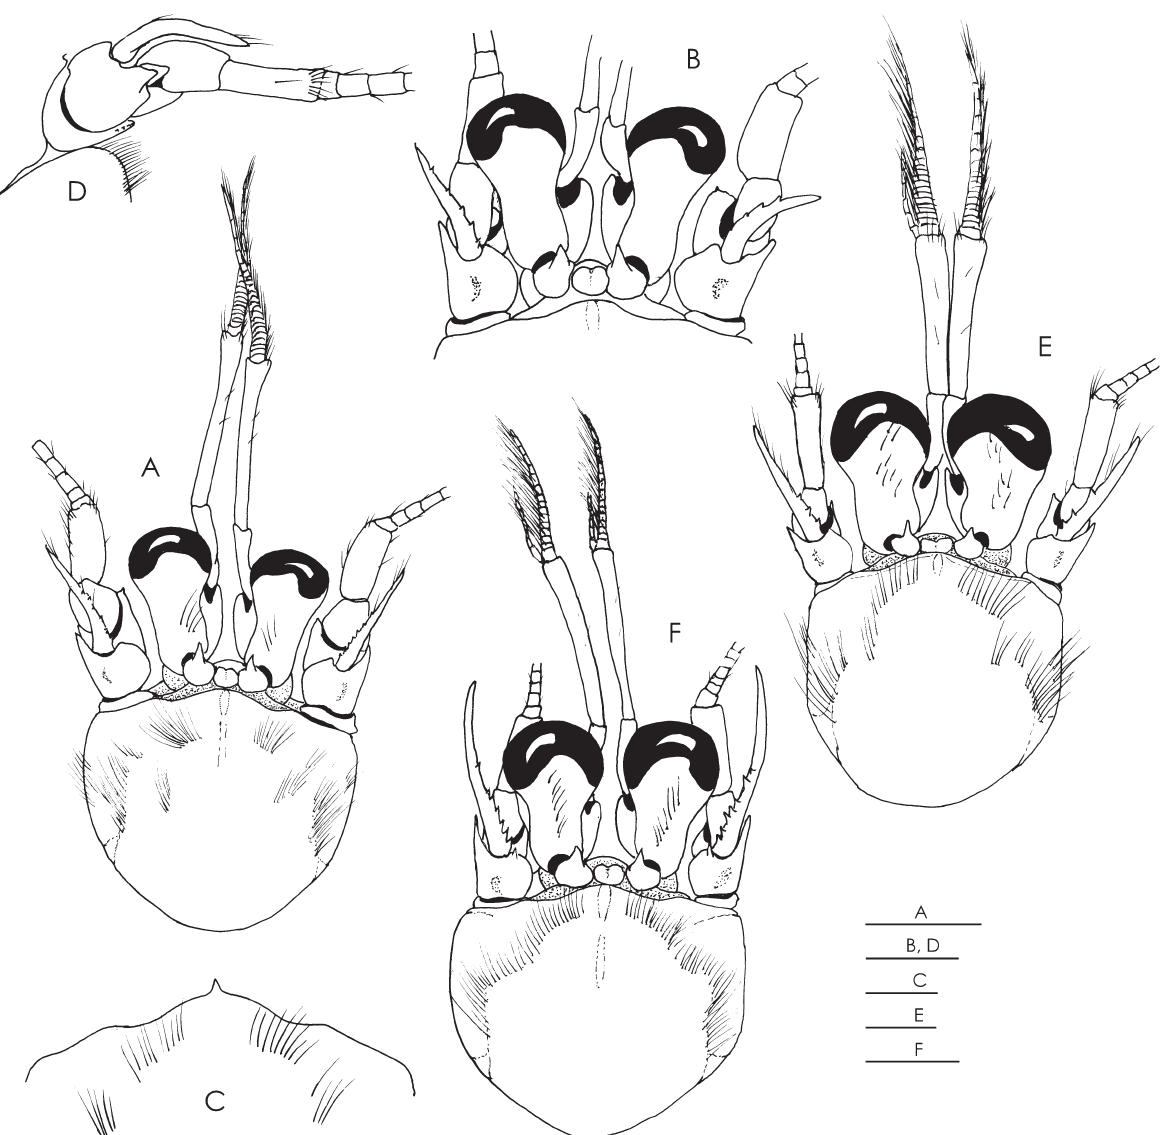
F IG . 1. – Strobopagurus breviacus sp. nov., New Caledonia: A, D, SMIB 5, stn DW 76, holotype M 6.1 mm (MNHN Pg 7116); B, SMIB 3, stn DW 18, paratype M 8.4 mm (MNHN Pg 7109); C, MUSORSTOM 5, stn 307, paratype juv F 2.9 mm (MNHN Pg 7104). A, shield and cephalic appendages; B, anterior portion of shield and cephalic appendages; C, anterior portion of shield; D, right antennal peduncle and anterolateral margin of branchiostegite, lateral view. Strobopagurus gracilipes (A. Milne-Edwards, 1891), New Caledonia, BIOCAL, stn DW 33, M 3.7 mm (MNHN Pg 7119): E, shield and cephalic appendages. Strobopagurus sibogae (de Saint Laurent, 1972), Indonesia, “ Siboga ” Expedition, stn 12, holotype ov F 7.4 mm (ZMA De103.109): F, shield and cephalic appendages. Scales equal 3 mm (A, F), 2 mm (B,